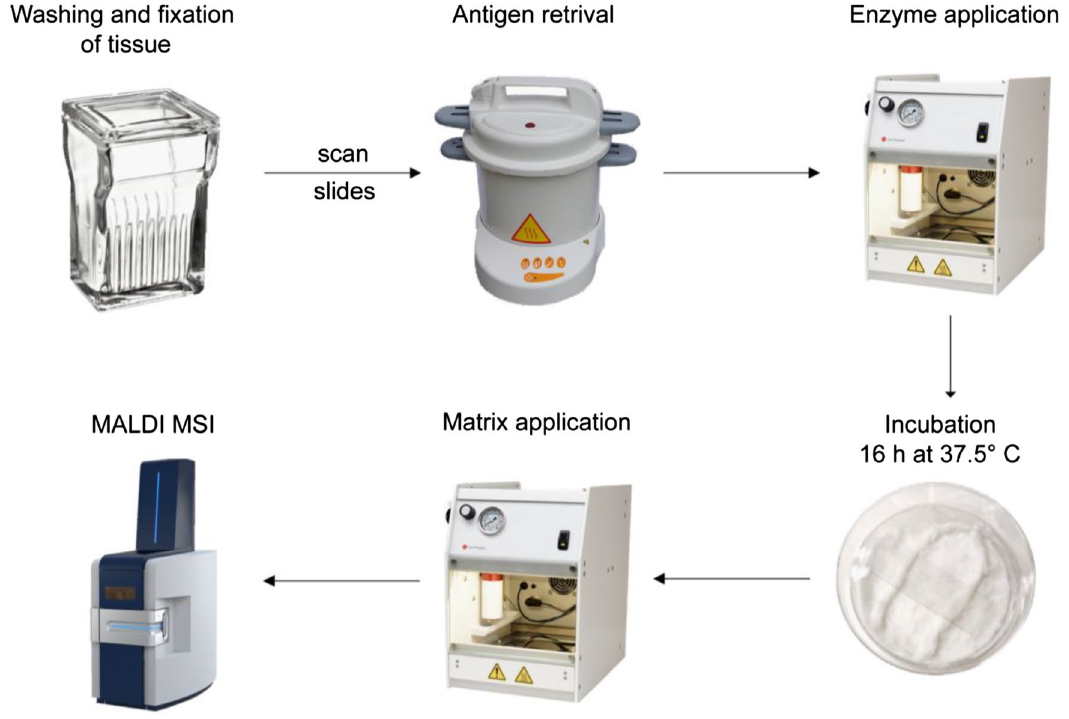
Figure 1. Experimental overview of N-glycan imaging protocol from sample preparation to MALDI